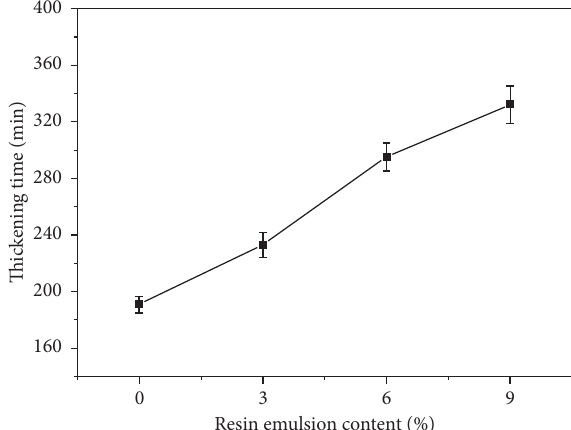
Figure 1: Thickening time of resin emulsion cement slurry.